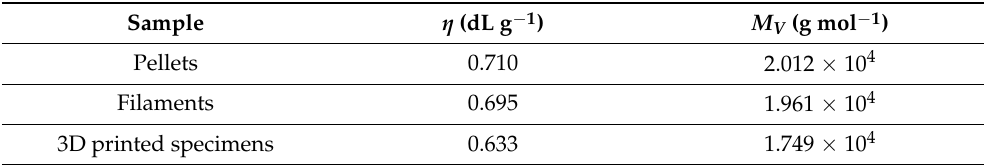
Table 2. The intrinsic viscosity ( η ) and average molecular weight ( M and 3D printed